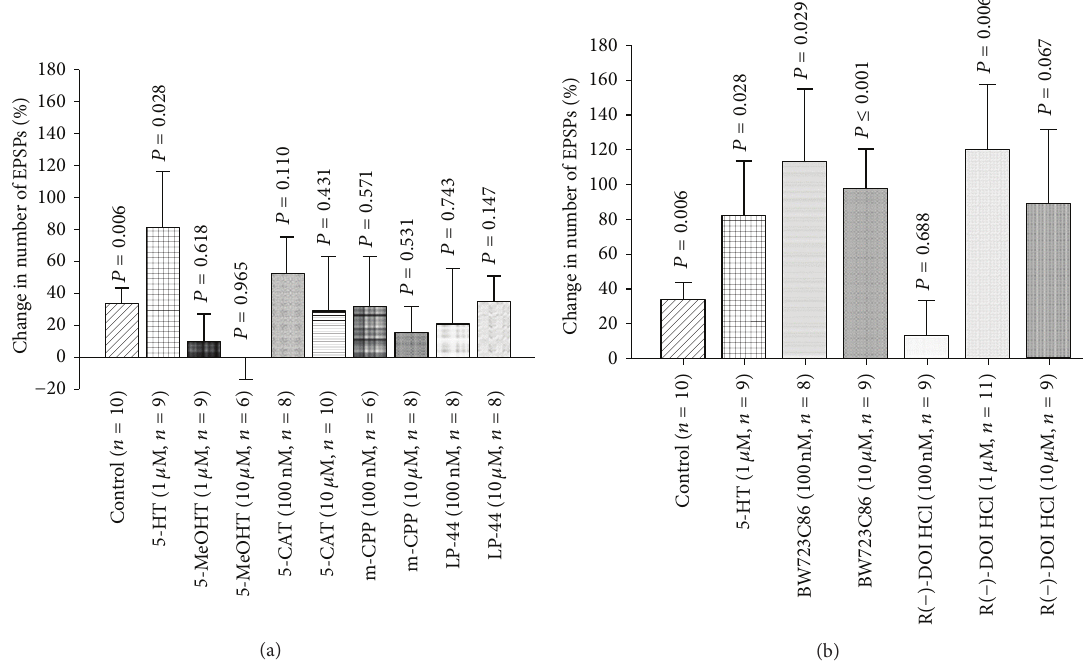
Figure 13: Modulation of motor-sensory function by 5-HT agonists. (a) Effect of various 5-HT agonists on the number of EPSPs in third- instar larvae. The control group was obtained by changing saline with fresh saline to observe the effect of the saline switching process on EPSPs frequency. The results show that 5-HT significantly increased the number of EPSPs; however, 5-methoxytryptamine (5-MeOHT), 5- carboxamidotryptamine maleate salt (5-CAT), 1-(3-chlorophenyl)piperazine hydrochloride (m-CPP), and LP-44 (5-HT7 agonist) did not produce significant changes. (b) 5-HT2 agonists, BW723C86 (100nM and 10 𝜇 M) (5-HT2B receptor agonist) and R( − )-DOI HCl (1 𝜇 M) (5- HT2 receptor agonist), significantly increased the motor-sensory circuit activity. Paired 𝑡 -test was used to compare the number of EPSPs in saline with saline that contained an agonist. Data represented as mean ± SEM. 𝑃 < 0.05 is